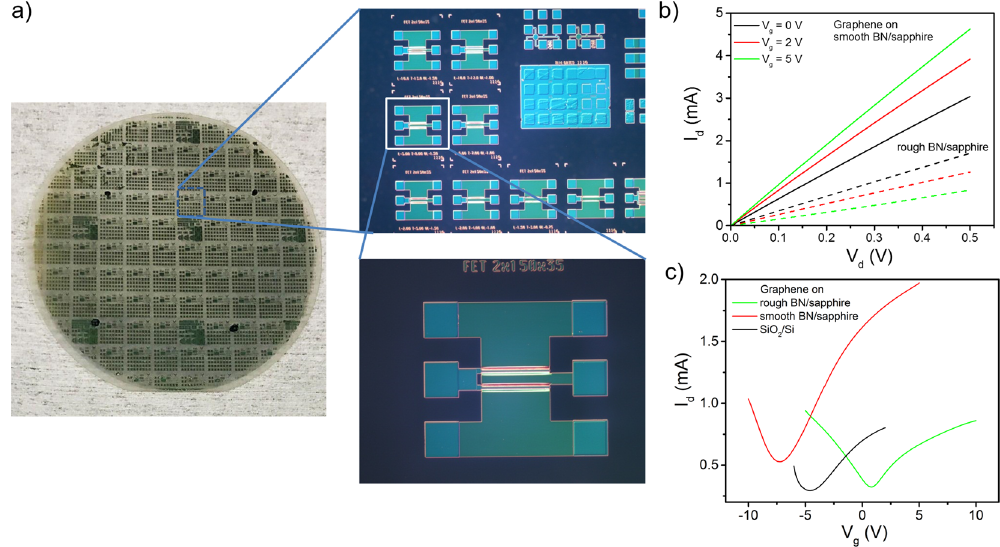
Figure 5. Graphene FET fabrication and characterization. ( a ) Optical images of processed 2” wafer and zoom in on devices. ( b ) Output and ( c ) transfer curves from representative devices with a 10 µ m channel length on smooth, rough BN/sapphire and SiO 2 /Si.